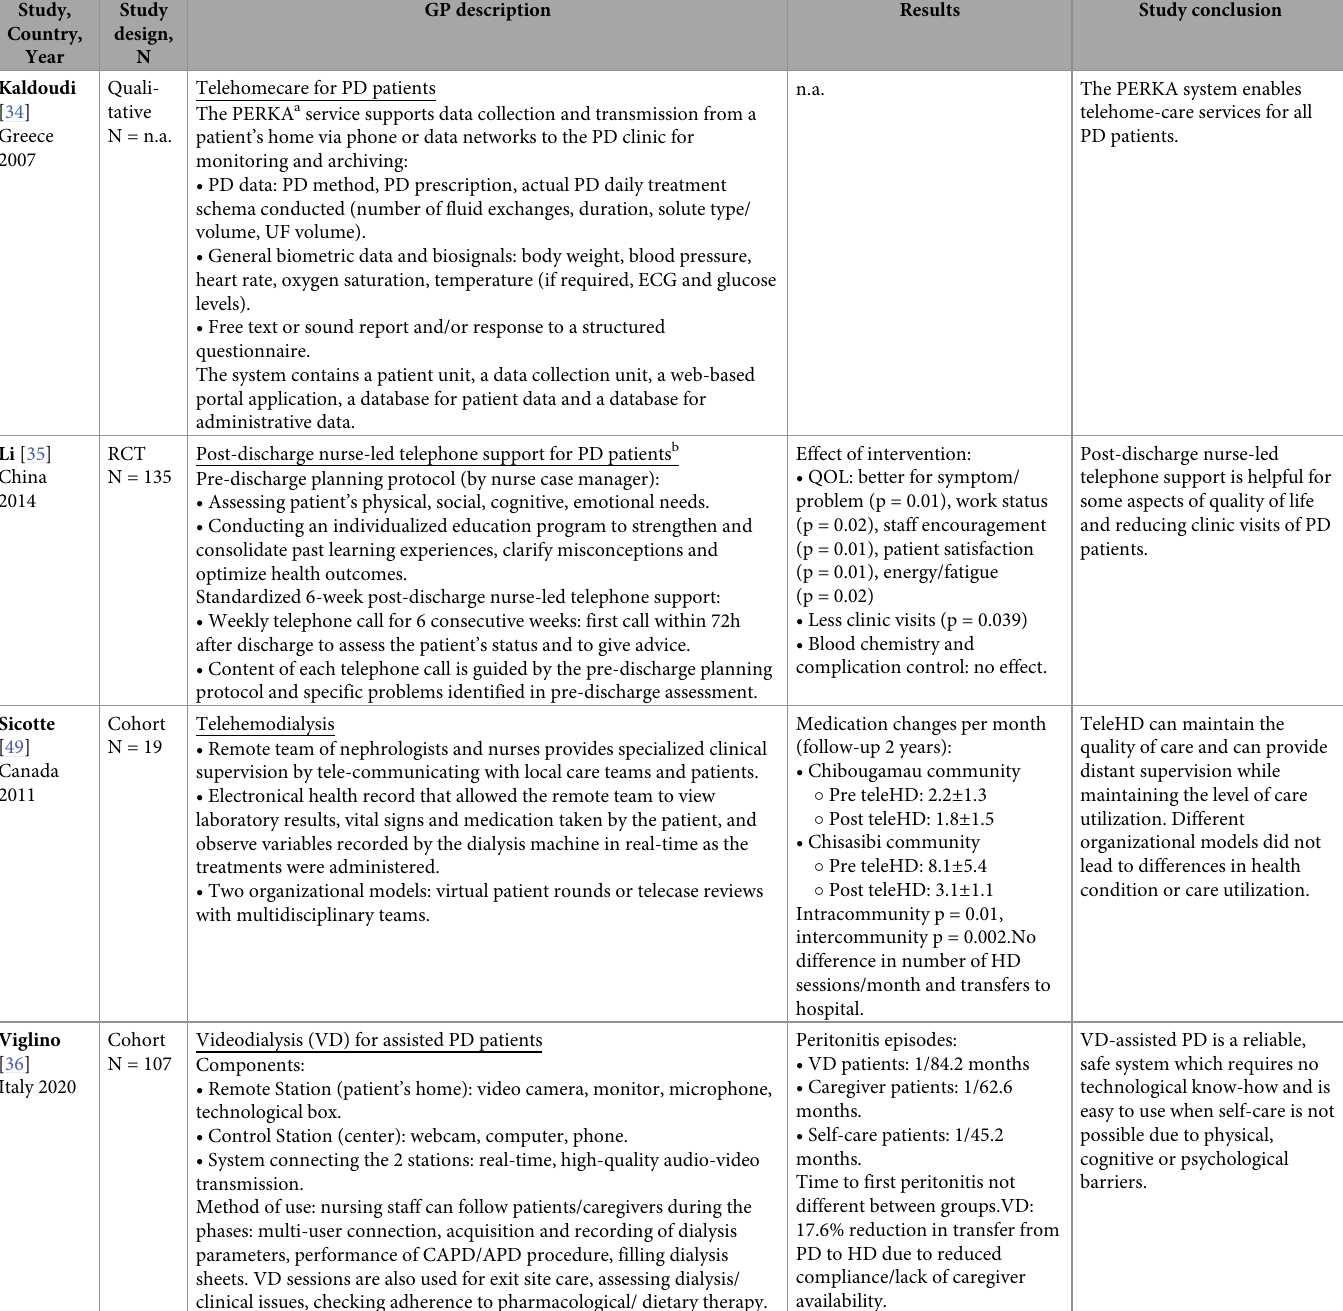
Table 4. Characteristics of studies on